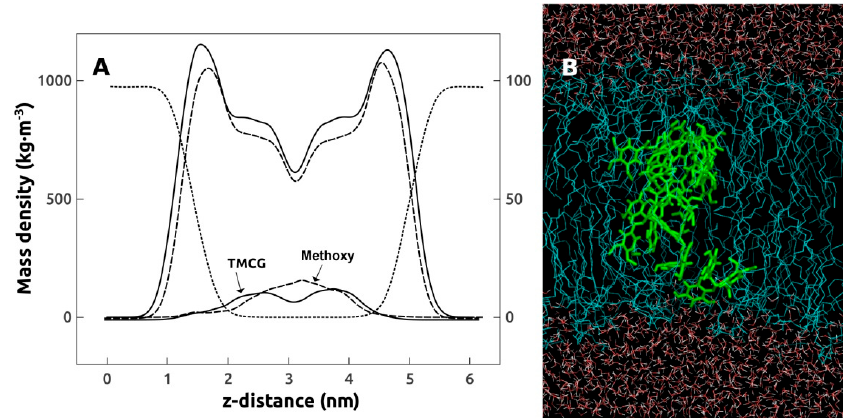
Figure 9. Molecular dynamics simulation on the interaction between TMCG and DMPE bilayers. (Panel A ) Mass density profiles of water (dotted); DMPE bilayer in the absence (solid) and presence of TMCG (dashed); TMCG (solid, arrowed); and metoxy groups of TMCG (dashed, arrowed). All density profiles are scaled according to the left axis except that of metoxy groups of TMCG which are amplified ( ≈ ×10) and scaled to the right axis; (Panel B ) Snapshot of the DMPE bilayer containing TMCG. The system under study is periodic in all directions, that is, the aqueous phase is continuous and TMCG can interact with both bilayer surfaces. Blue lines correspond to DMPE molecules and light-green lines to TMCG molecules. Red dots correspond to water molecules.